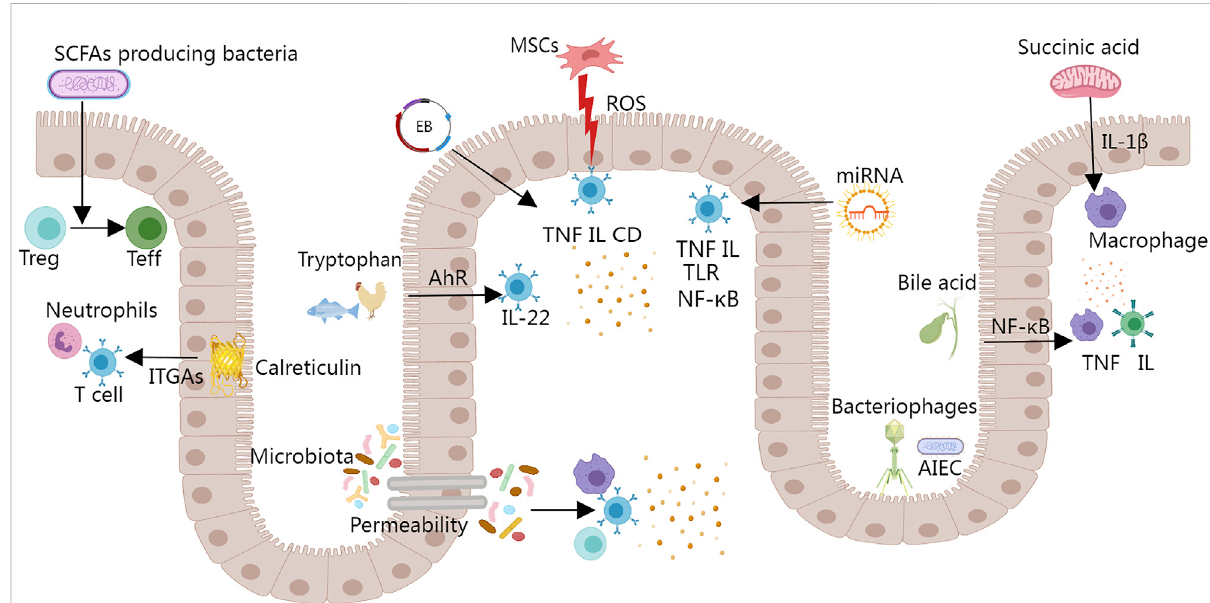
FIGURE 3 The current IBD treatment methods and potential targeted regulatory sites. (Treg, regulatory T cell; Teff, effector T cell; ITGAs, integrin α subunits; MSCs, mesenchymal stem cells; ROS, reactive oxygen species; EB, engineered bacteria; AhR, aryl hydrocarbon receptor; IL, interleukin; TNF, tumor necrosis factor; CD, cluster of differentiation; TLR, Toll-like receptor; NF- κ B, nuclear factor- κ